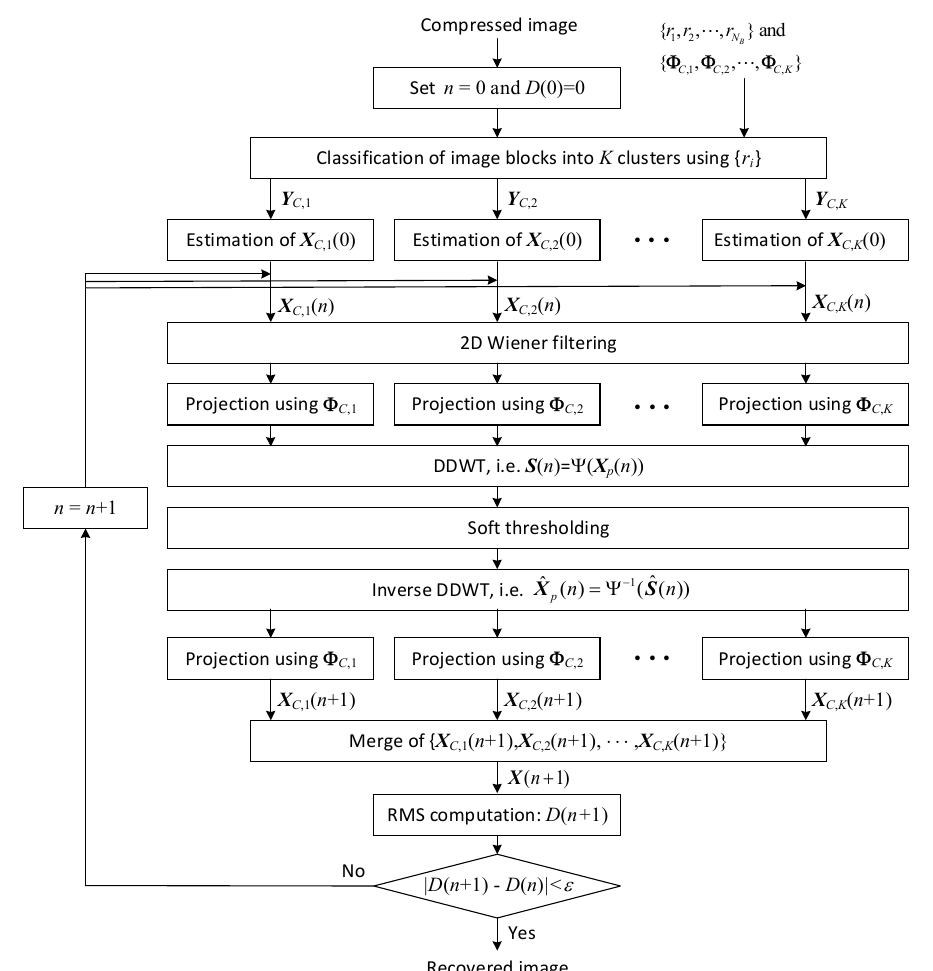
Figure 4. Image reconstruction using the proposed clustered BCS. where X p , k ( n ) ∈ R B 2 × N C , k is the projected matrix for k th cluster and k = 1, 2, · · · , K . { X p , k } are merged to X p ( n ) , and X p ( n ) is converted to S ( n ) through the DDWT Ψ ( · ) for sparse representation, i.e.